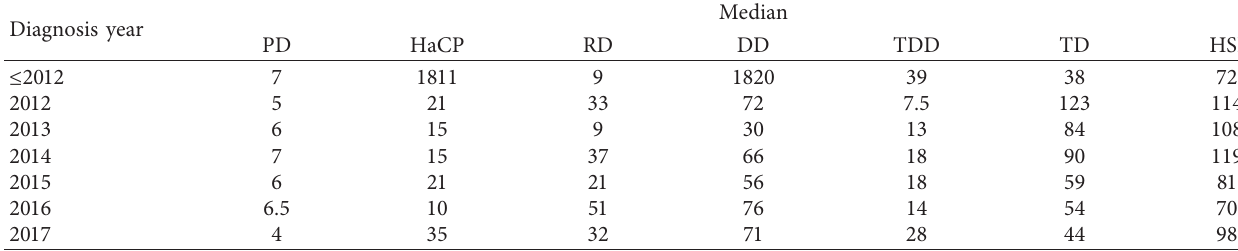
Table 3: Evolution of the care pathway over the years.